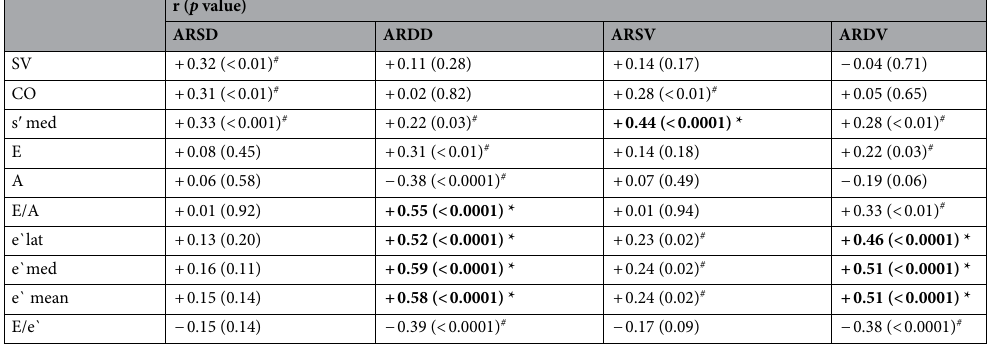
Table 3. Correlations between aortic root parameters and standard echocardiographic Doppler parameters. *Moderate correlation. # Weak or negligible correlation.